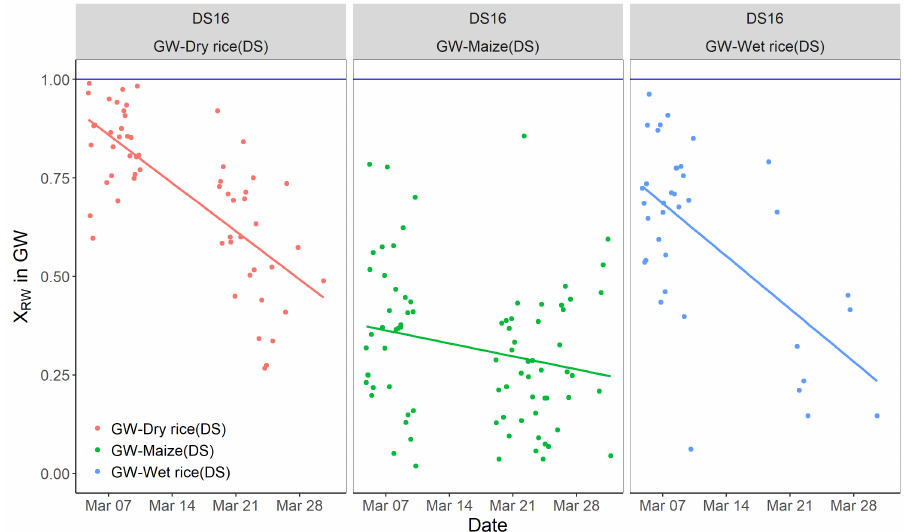
Figure 9. Fraction of rainwater (X RW ) in the groundwater (GW) of different crops (dry rice, maize, and wet rice) during the dry season (DS), calculated using Equation (3). Maximum fraction of rainwater is represented by X = 1 (100%) (blue horizontal line), and the maximum fraction of irrigation water is represented by X = 0. The red, green and blue regression lines represent the decreasing trend of rainwater fraction in groundwater with sampling time for dry rice ( left panel ), maize ( middle panel ) and wet rice ( right panel